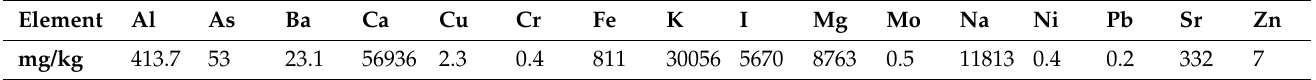
Figure 1. Processing of Sargassum muticum . ( a ) Collection; ( b ) washing; and ( c ) drying with color change. Table 1. Chemical composition of Sargassum muticum algae.